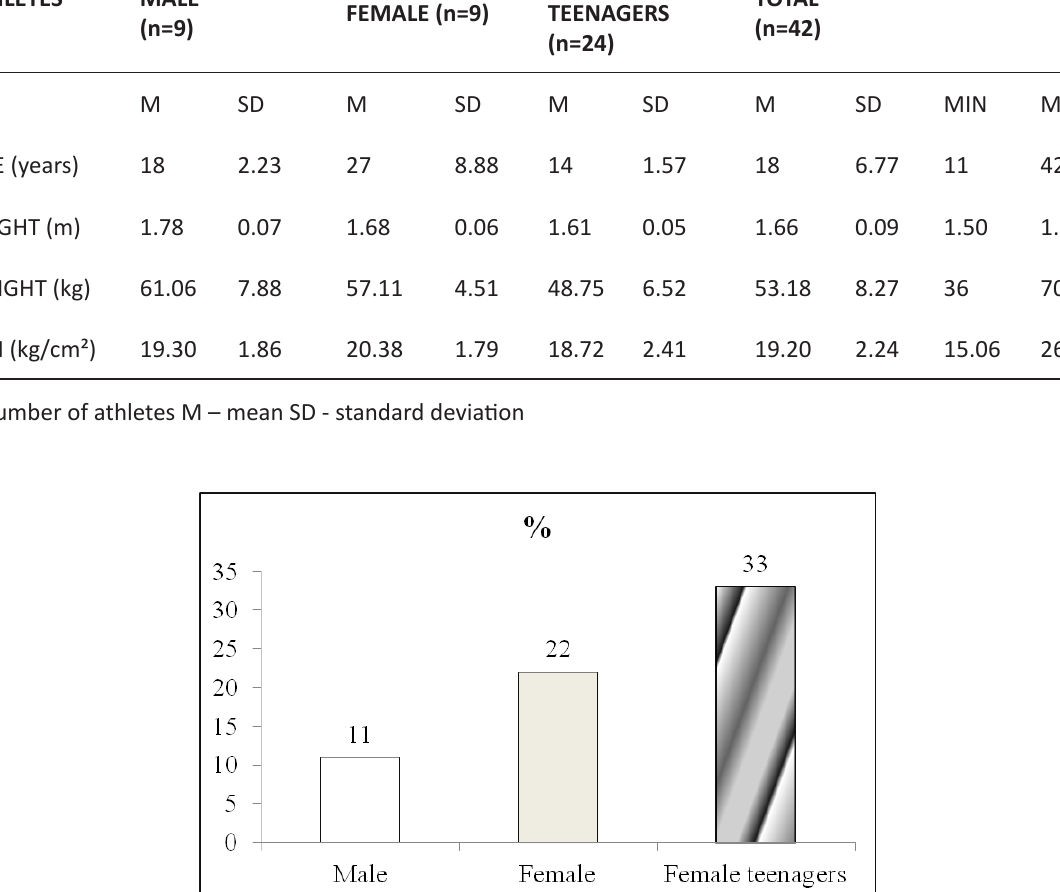
Table 1. The anthropometric characteristics of the Greek race walkers ATHLETES